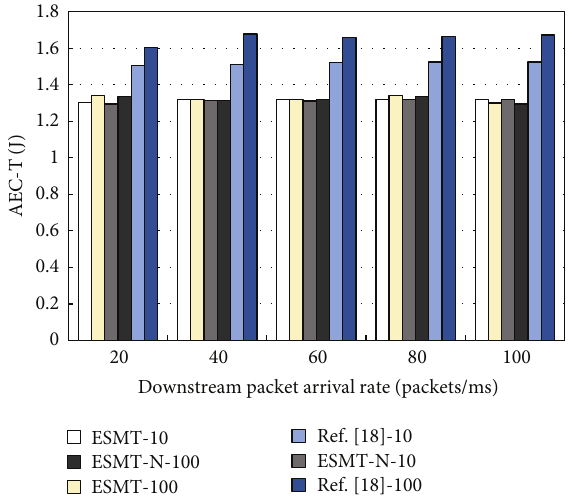
Figure 12: Comparison of AEC-T under the two scenarios.